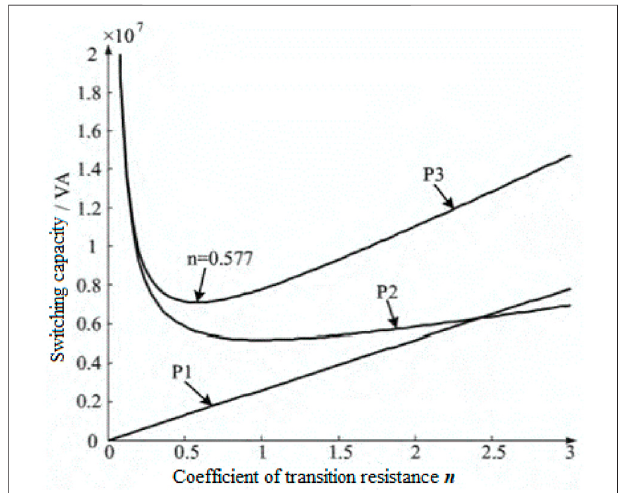
FIGURE 3 | Relationship curve between capacity and transition resistance coef fi